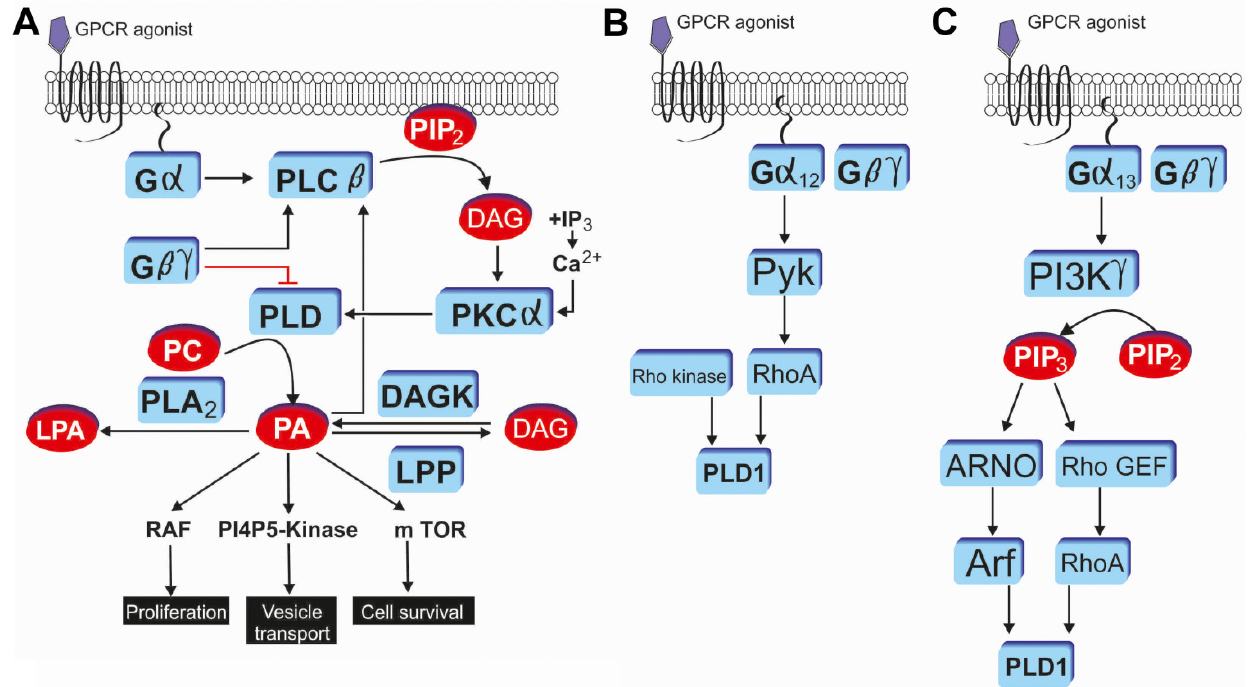
Figure 2. G protein coupled receptor induced PLD activation and phosphatidic acid (PA) mediated signaling through G α q and protein kinase C ( A ); G α 12 and RhoA ( B ); and G α 13 and Arf ( C ). Modified from Selvy et al.